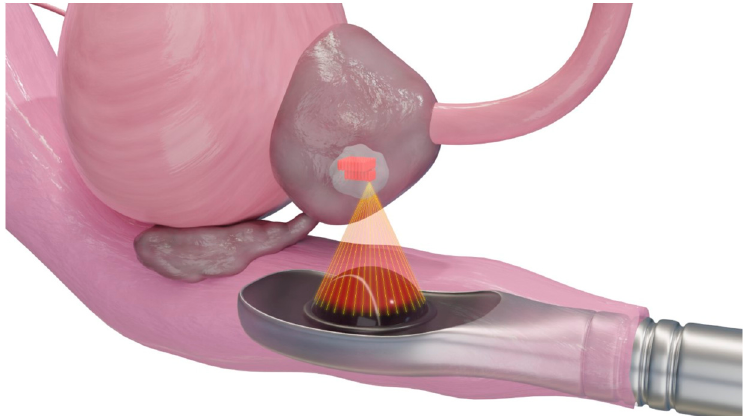
Figure 6. Schematic presentation of high-intensity frequency ultrasound for ablation of a prostate tumor . The extracorporeal transducer generates high-intensity ultrasound to carry and propagate energy onto a focused area deep within tissue media. Temperatures are raised to a level that is sufficient for thermotherapeutic effects, resulting in coagulation necrosis [38,39].